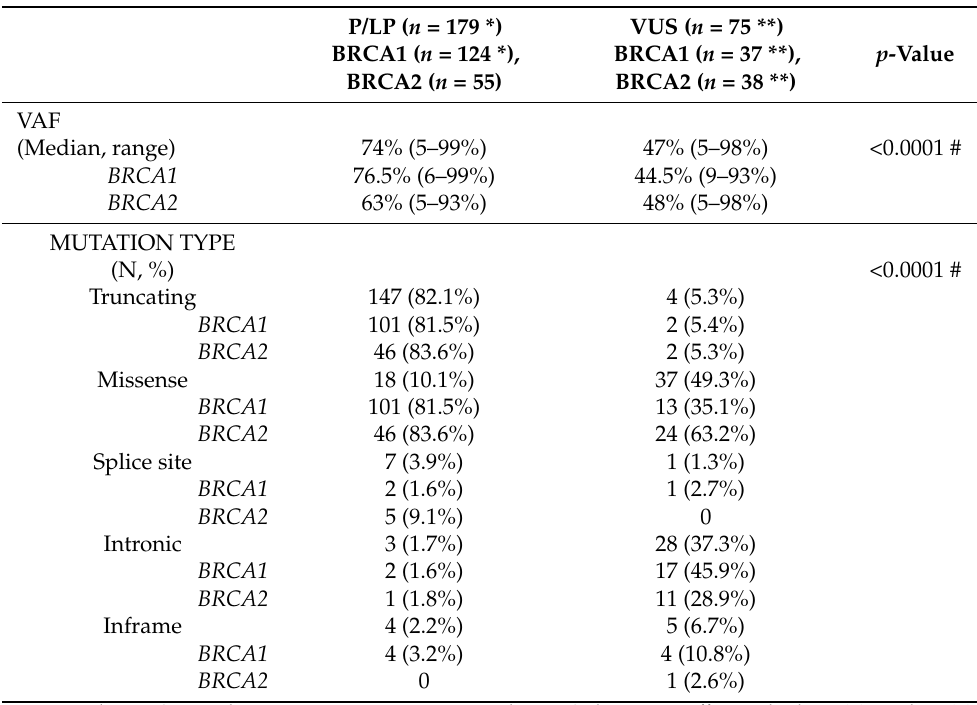
Table 2. Characteristics of pathogenic/likely pathogenic variants and VUS. Molecular characteristics were tabulated overall and according to BRCA1 or BRCA2 genes